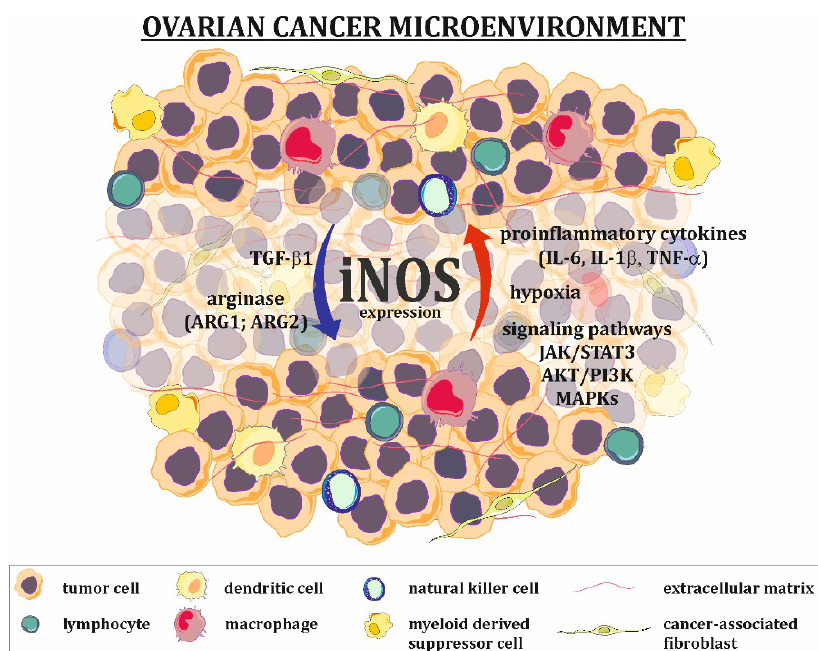
Figure 2. Regulation of iNOS expression in ovarian cancer microenvironment. Factors present in the ovarian cancer microenvironment, such as proinflammatory cytokines (IL-1 β , IL-6, TNF- α ), as well as hypoxia and overactivation of some signaling pathways (e.g., JAK / STAT3, AKT / PI3K, MAPKs), are responsible for upregulation of iNOS expression in tumor cells, while agents like TGF- β 1 and arginase downregulate its expression.